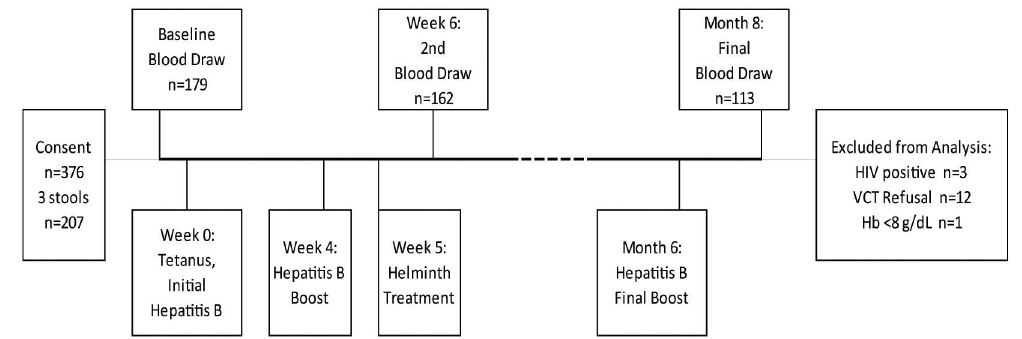
Fig 1. Study timeline showing study design and participant loss to follow-up. Students and staff were consented, enrolledinto the study and requiredto submit 3 stool samples, receive hepatitis B vaccine series and tetanus toxoid boost, submit to blood draws, and attend a Volunteer Counseling& Testing clinic. A total of 376 individuals signedconsent forms with 146 individuals giving at least 2 blood samples thus meeting the